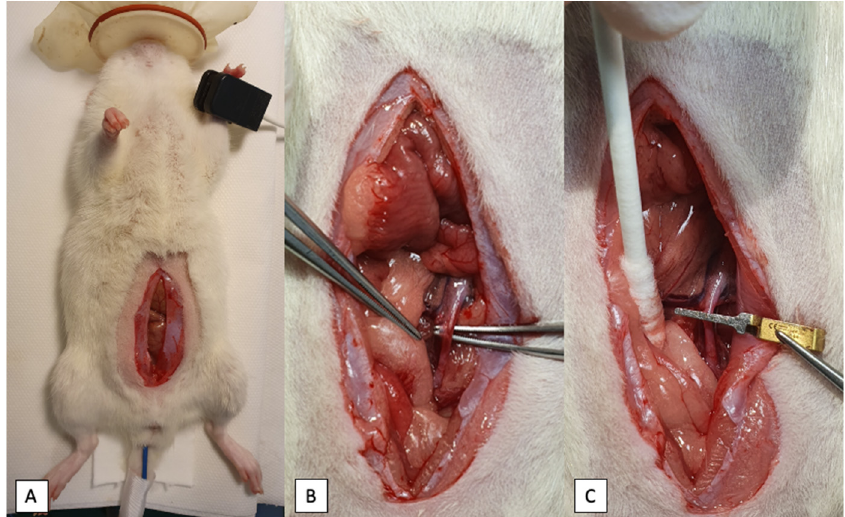
Figure 4. Surgical procedure for IR injury model. ( A )—positioning of an animal prior to experiment, a 3–4 cm midline laparotomy. ( B )—identification of the vessels, dissection of the aorta. ( C )—occlusion of the aorta with microvascular bulldog clamp.